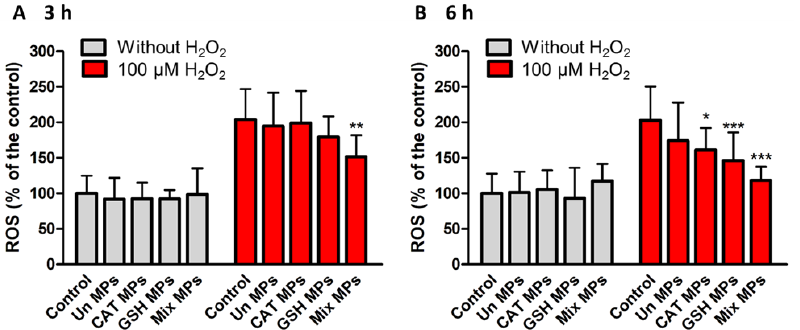
Figure 11. Intracellular ROS levels of HT-29 cells using DCFH-DA assay measured after ( A ) 3 h and ( B ) 6 h of incubation with cell medium (control), unloaded MPs (Un MPs) and the SLMs containing antioxidant agents (GSH MPs, CAT MPs and Mix MPs). Values are expressed as means ( n = 6) ± SD and the level of significance was set at the probabilities of * p < 0.05, ** p < 0.01 and *** p < 0.001 compared to the control sample with the same pre-treatment.